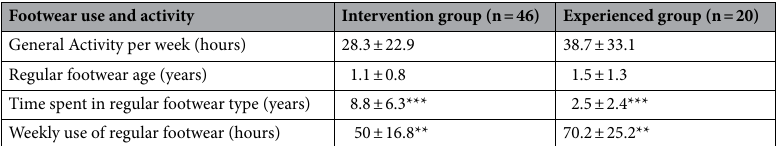
Table 5. Participant and footwear history comparisons between the total intervention study group, but before the study, and the experienced group. p-values of < 0.01 or < 0.001 are represented by ’**’, and ‘***’ respectively. Regular footwear is the actual footwear the subjects wore most regularly when they started the study. Footwear type is the type design of the footwear (e.g., trainers, dress shoes, etc.).